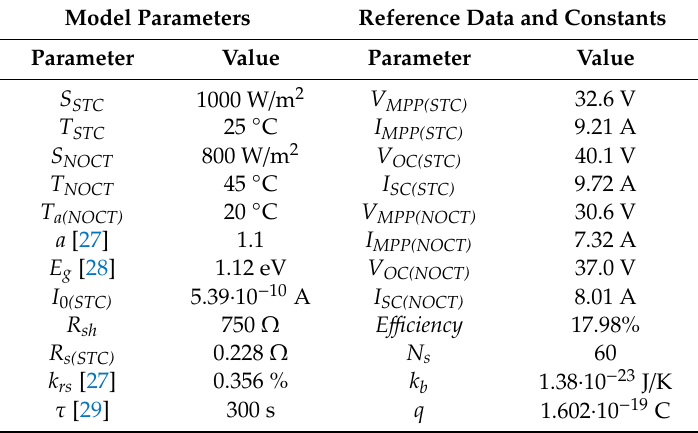
Table 3. PV module